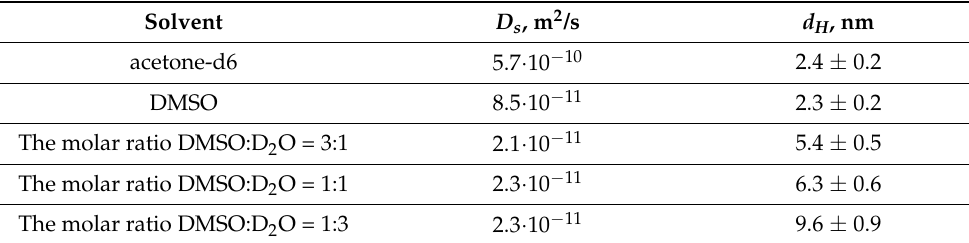
Table 2. The self-diffusion coefficients D s and the diameters d H from Equation (2) for fullerene derivative VI , the solution concentration C = 8 mg/mL.